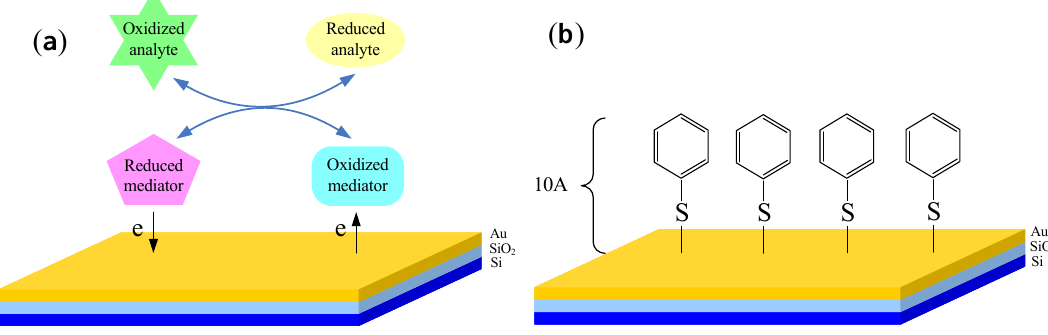
Figure 8. Schematic diagram of the interface between biological analyte and EMIS structured sensor. ( a ) Redox couples functioning as mediators used to be added into samples, which usually can be Fe(III)/Fe(II) or quinhydrone; ( b ) Modified interface using electron transport promoter to accelerate electron transport between analyte and sensor surface, here 4-PySH is taken as an example.